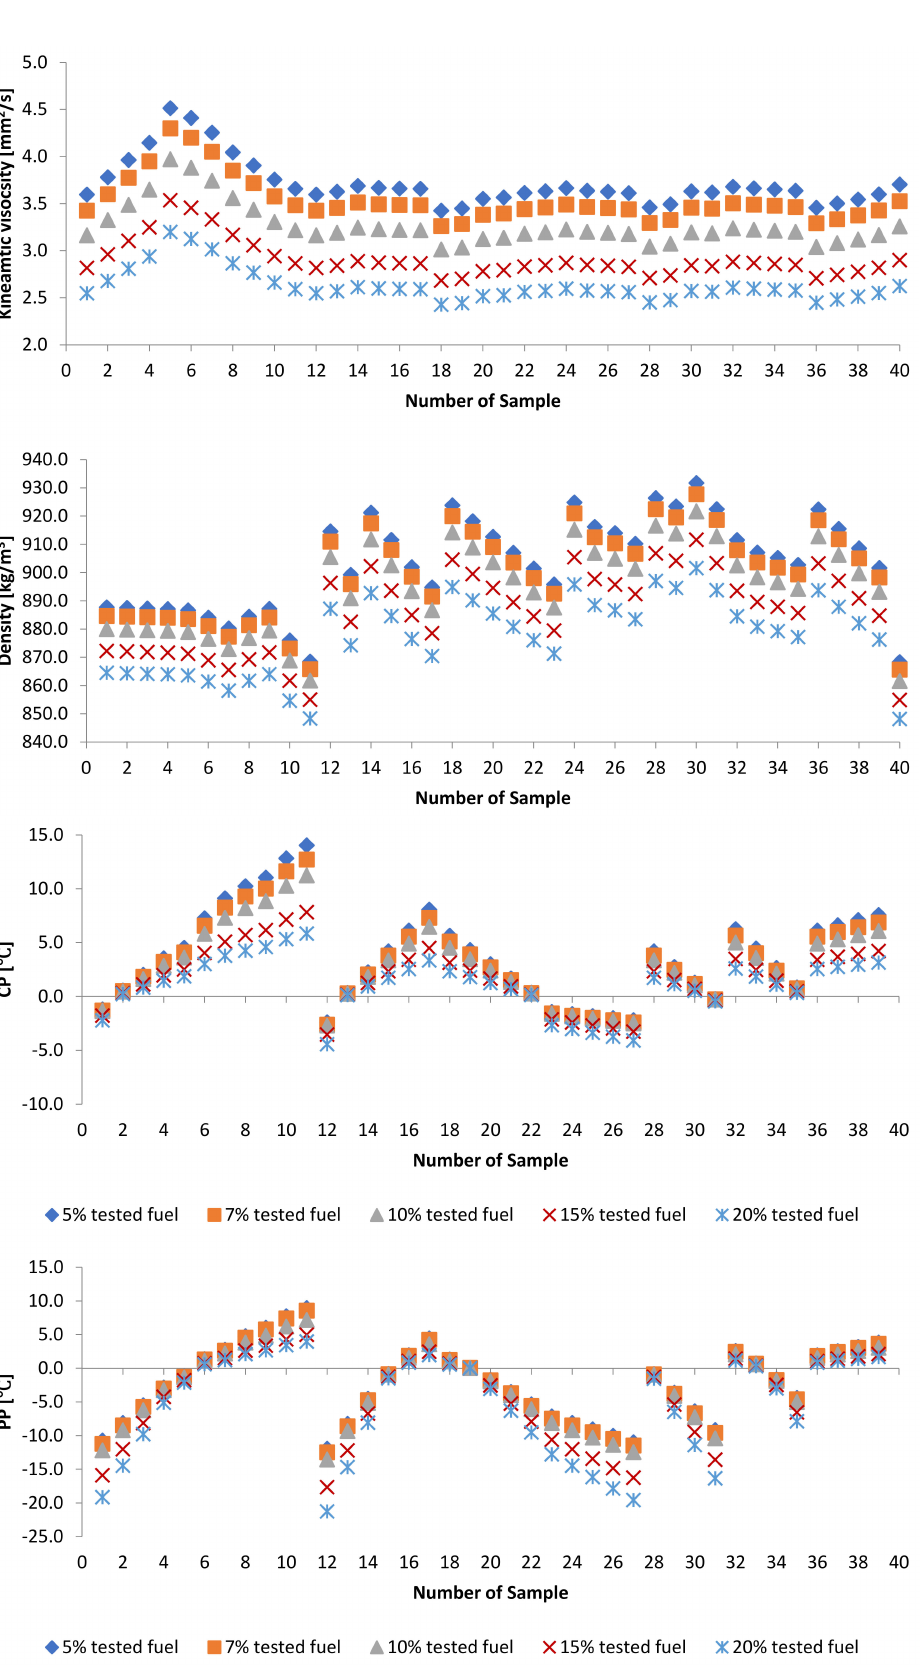
Figure 9. Properties of biodiesel-BF blends with various volume